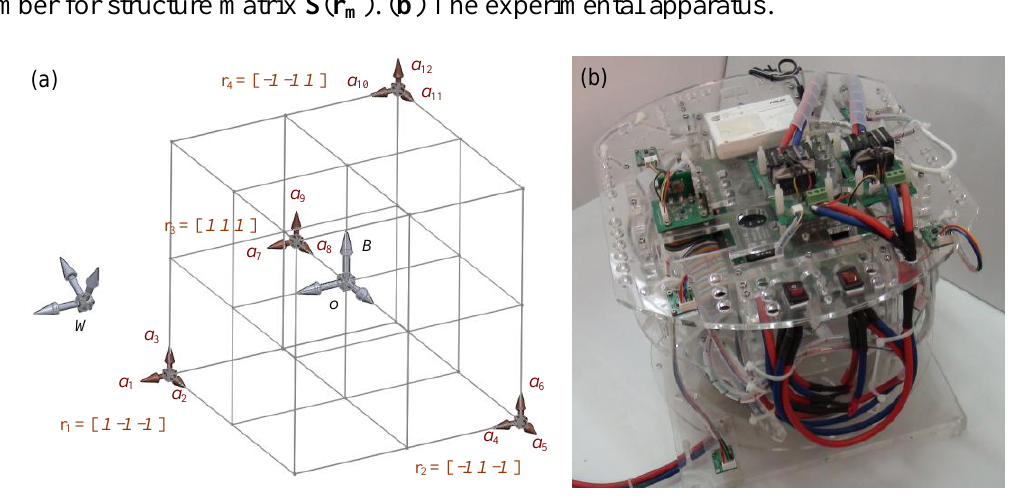
Figure 2. ( a ) The configuration of four 3-axis accelerometers that yields the best condition number for structure matrix S ( r ). ( b ) The experimental m